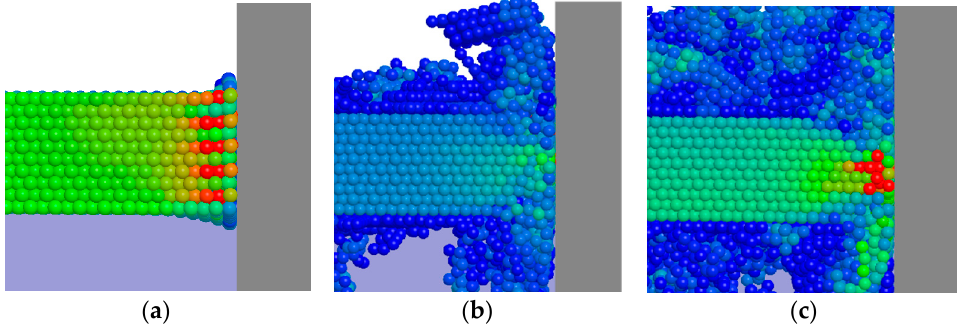
Figure 10. Crushing failure of sea ice acting with a vertical structure: ( a ) t = 17 s; ( b ) t = 59 s; ( c ) t = 200 s.